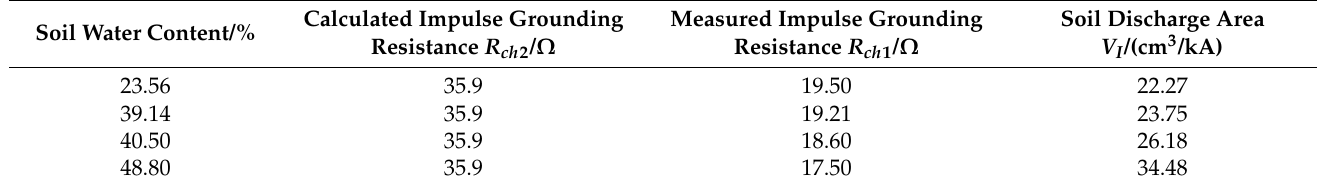
Table 1. V I and R ch2 of soil with the same resistivity that is 50 Ω · m and different water content.